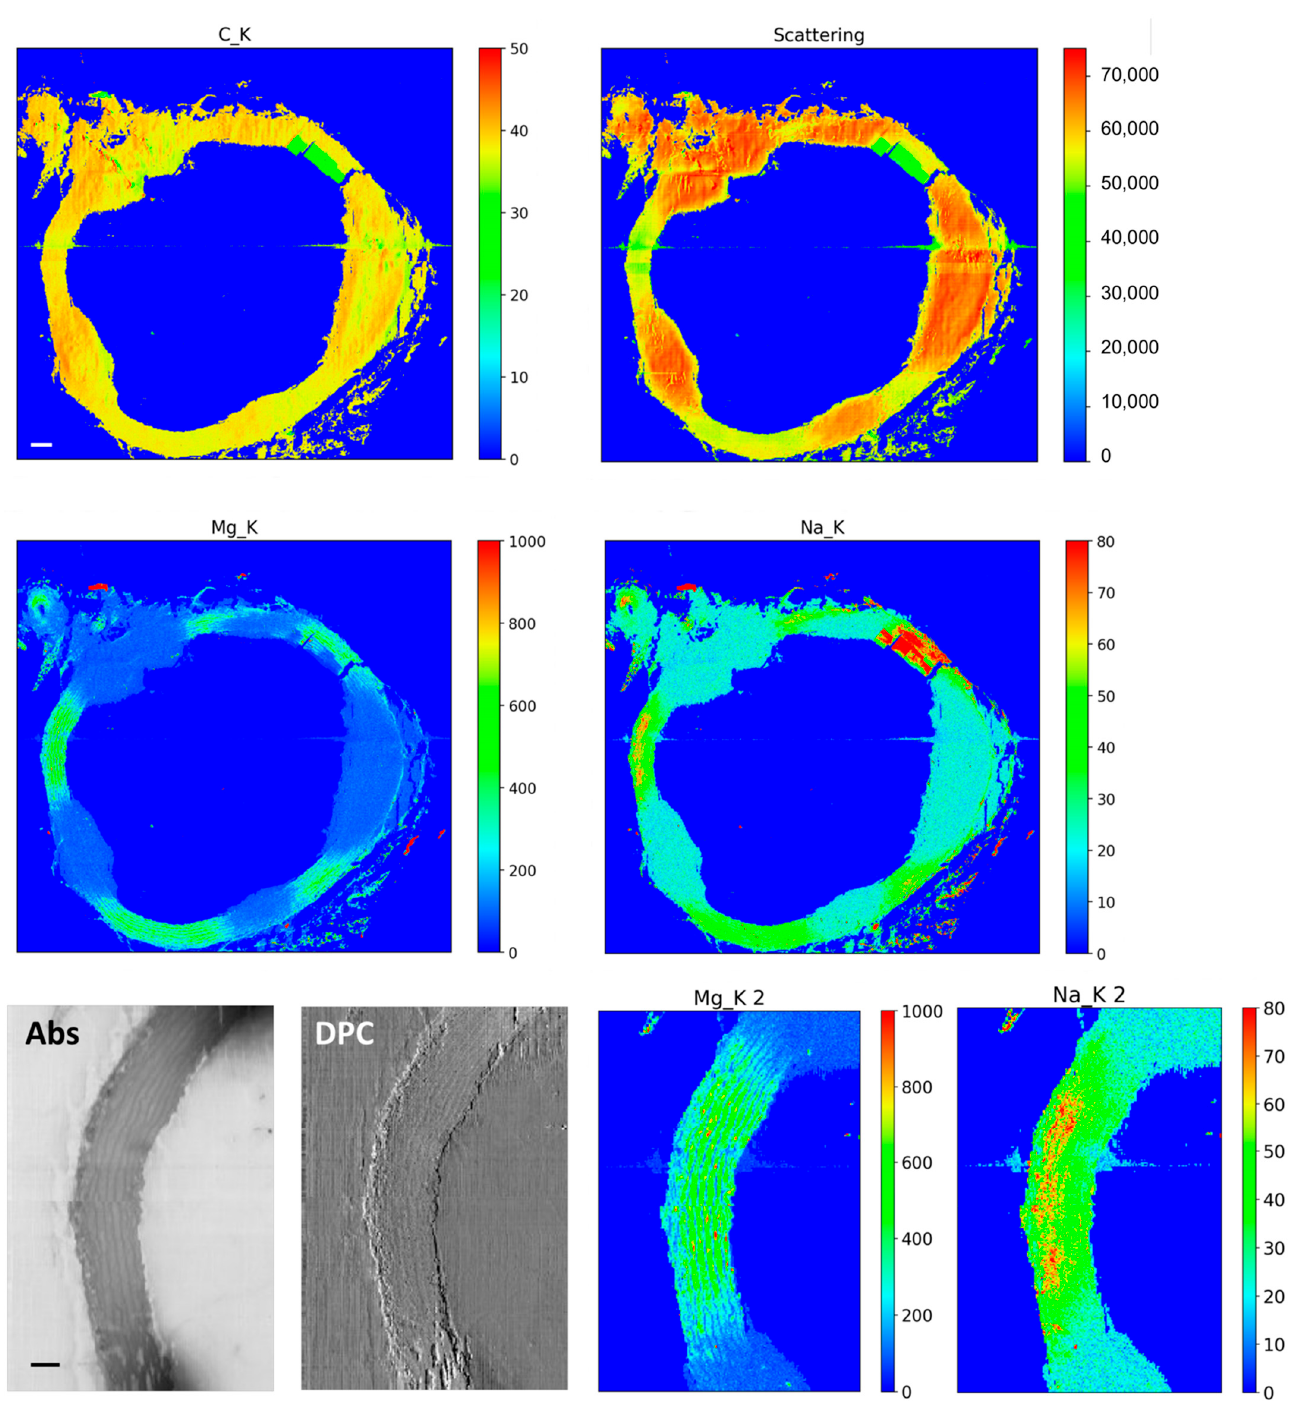
Figure 12. XRF maps of C, Na, Mg, and scattering signal, collected on the coronary artery section shown in Figure 11, at 1.7 keV, with a step size of 2.5 µm and a 1 s acquisition time per pixel, only on the areas with an absorption signal below a specific pre-selected threshold. The bottom row depicts a sub-region of the absorption (Abs) and differential phase contrast (DPC) images shown in Figure 11 together with the corresponding LXERF maps of Mg and Na (Panels Mg_K 2 and Na_K 2, respectively). Scale bar in map C is 100 µm, while in panel Abs, it is 50 µm.